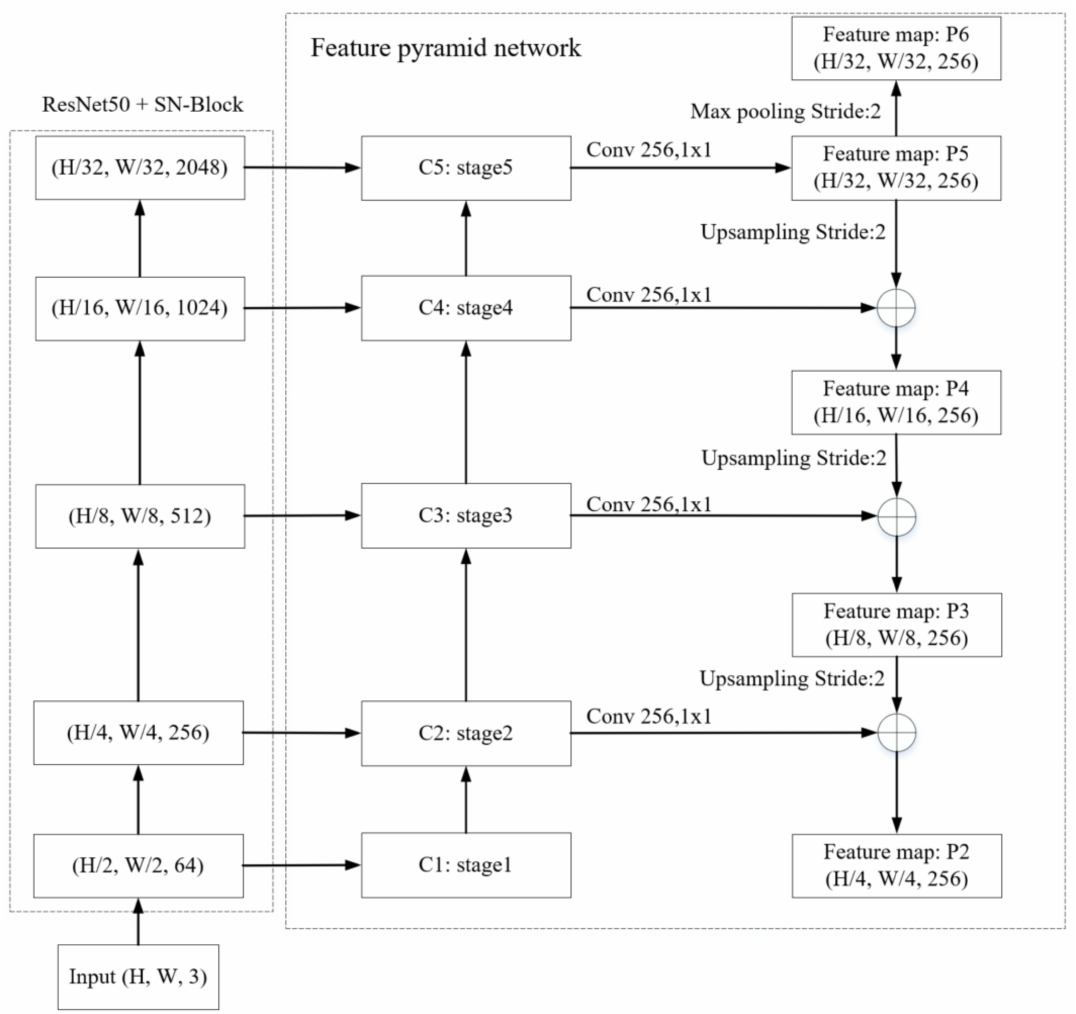
Figure 7. The structure of the feature pyramid